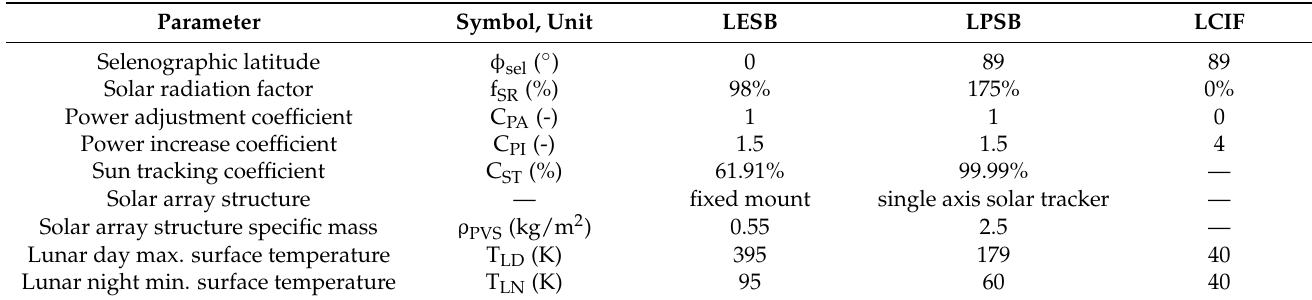
Table 21. Assumptions for lunar base case studies.